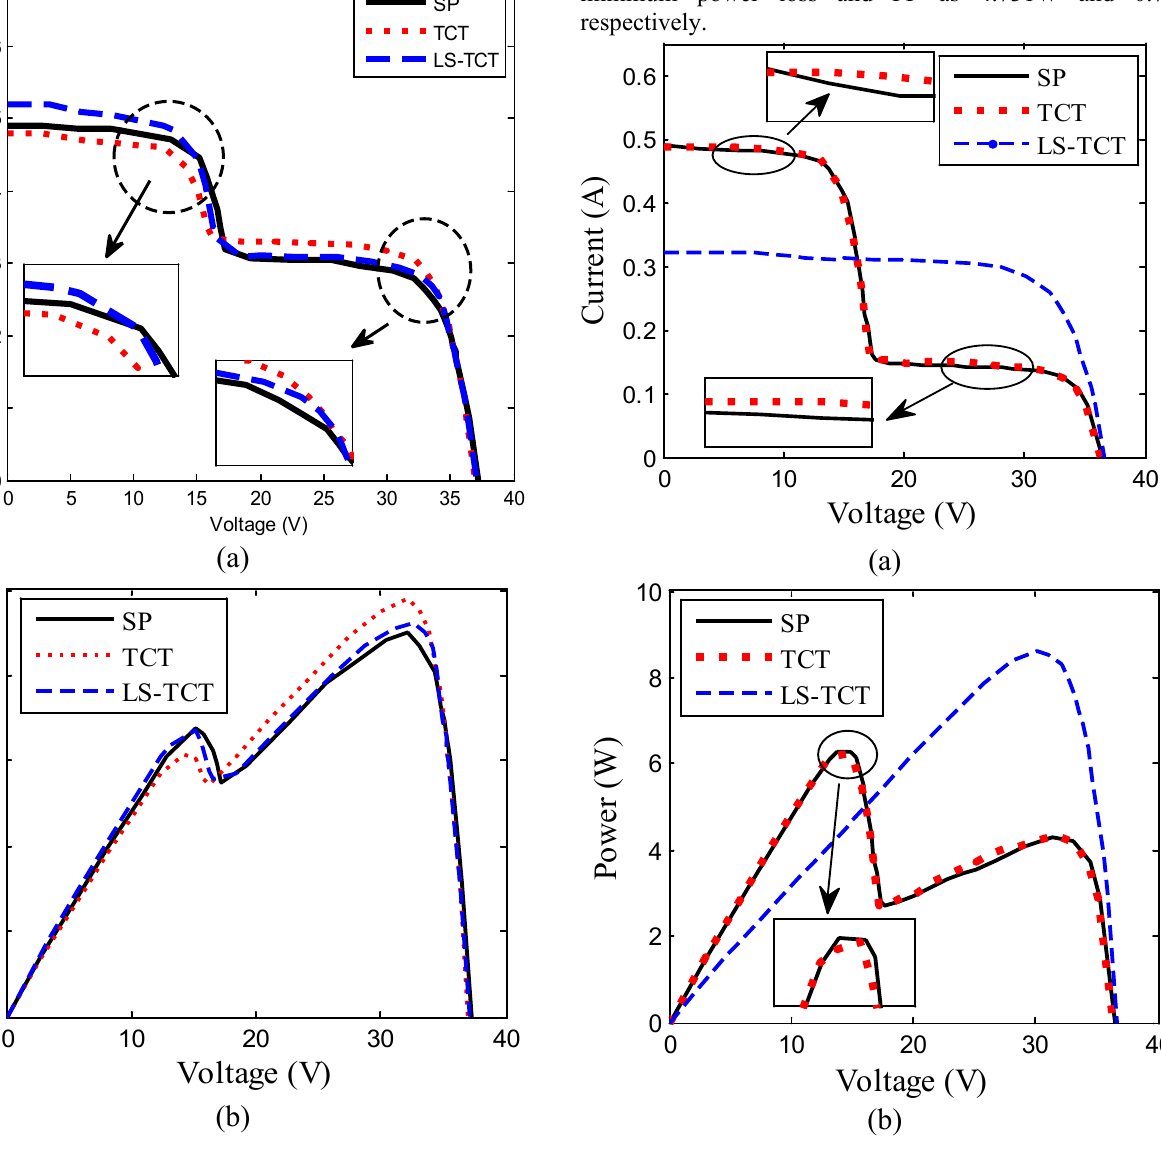
Figure 7. (a) I-V (b) P-V curves of SP, TCT and LS- TCT solar PV array under shading case-1